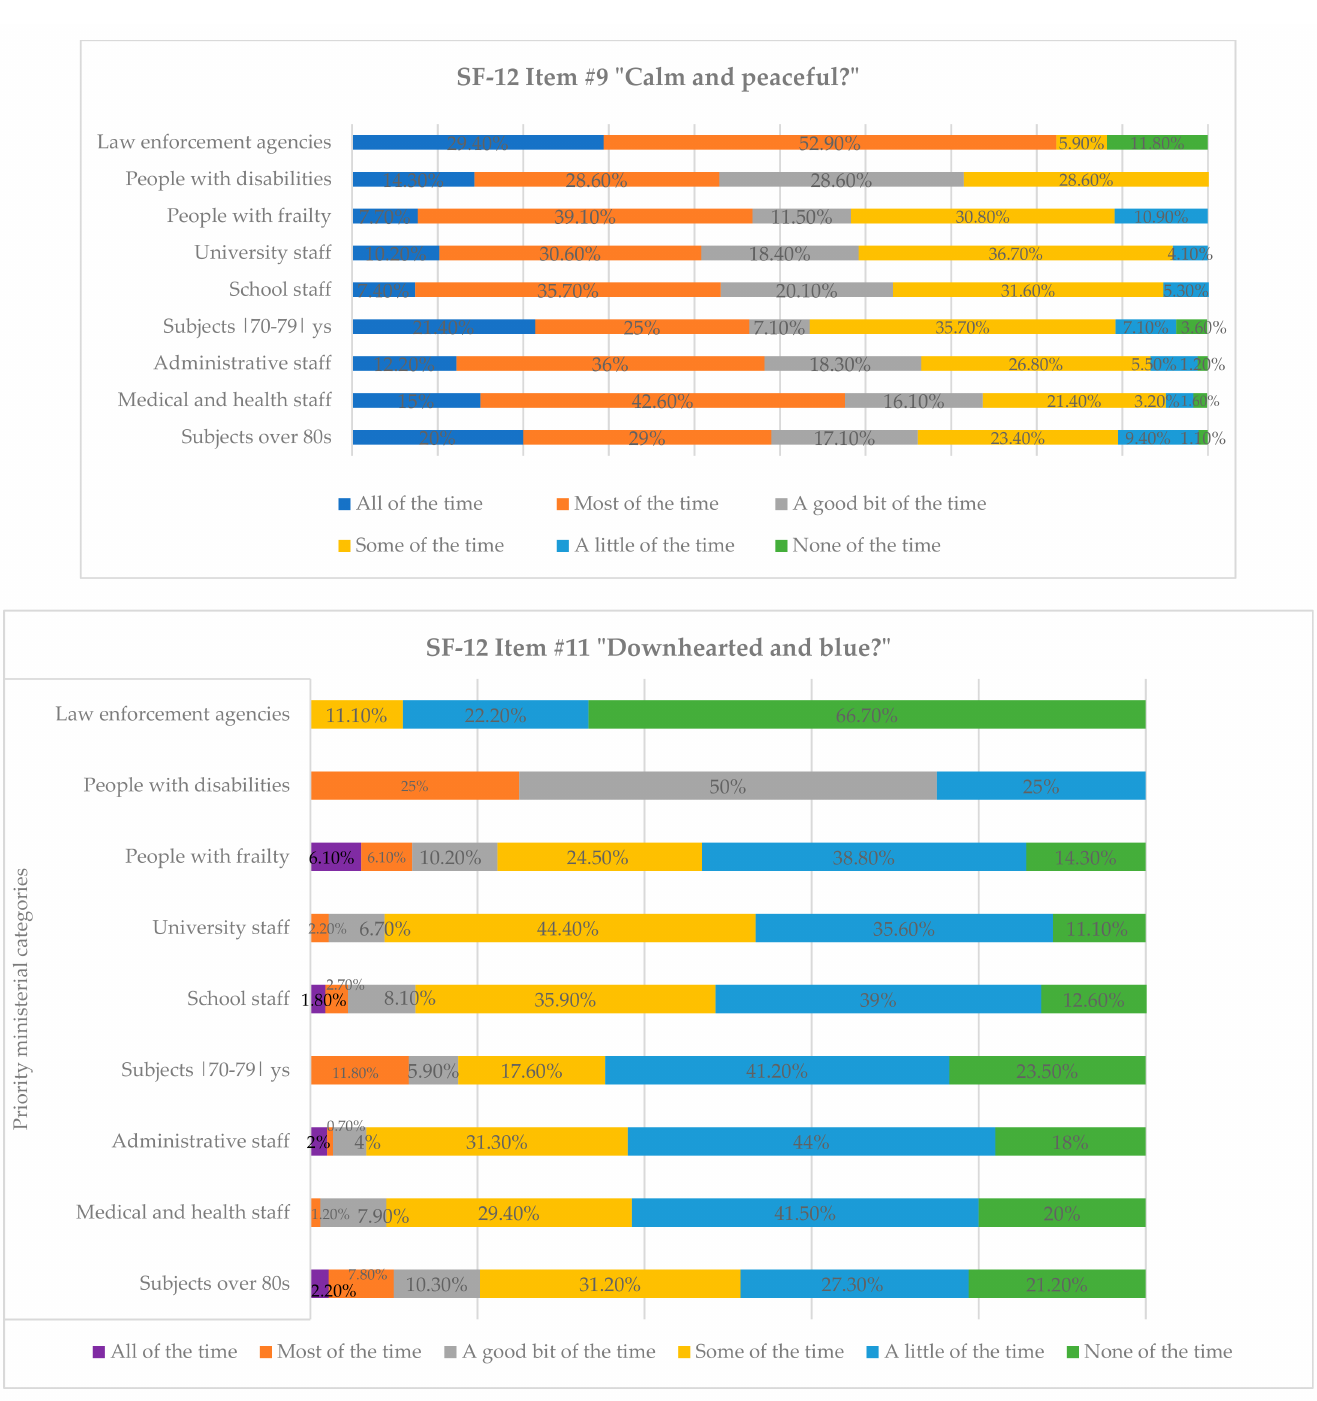
Figure 2. Percentage of response frequencies relative to items #9 and #11 of SF-12 divided by vaccine priority ministerial